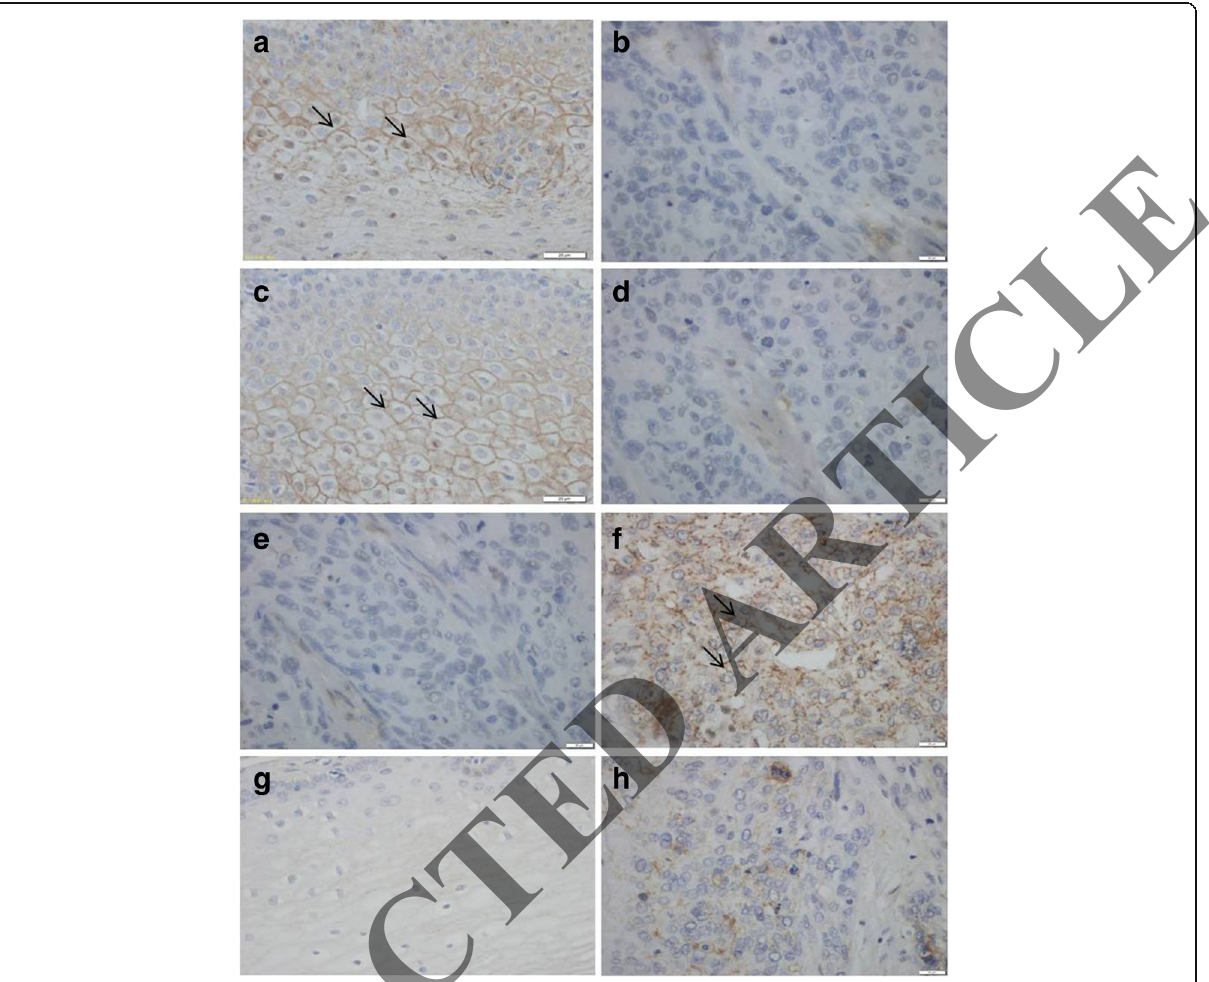
Fig. 1 Membrane expression of claudin proteins in human nasopharyngeal carcinoma and non-neoplastic mucosae. a , claudin-2 expression in tissues: non-neoplastic mucosal tissues (left) and in human nasopharyngeal carcinoma tissue (right) (b) . c , expression of claudin-5 was detected in non-neoplastic mucosal tissues (left) compared with human nasopharyngeal carcinoma tissues (right) (d). e , claudin-8 expression in non- neoplastic mucosal tissues a (left) compared with human nasopharyngeal carcinoma tissues (right) (f). g , claudin-9 expression was detected in non-neoplastic mucosal tissues (left) and in human nasopharyngeal carcinoma tissues (right) (h)